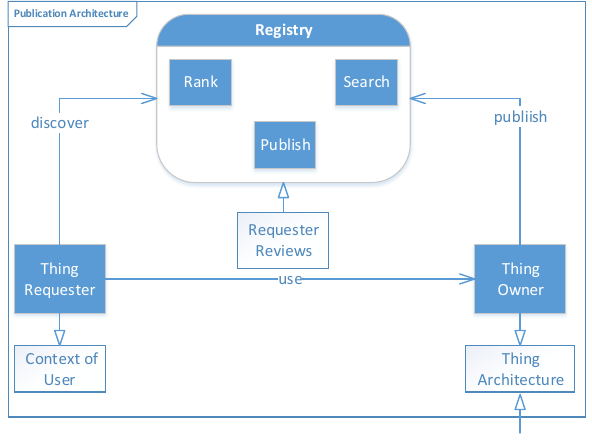
Figure 2. SOA-based IoT